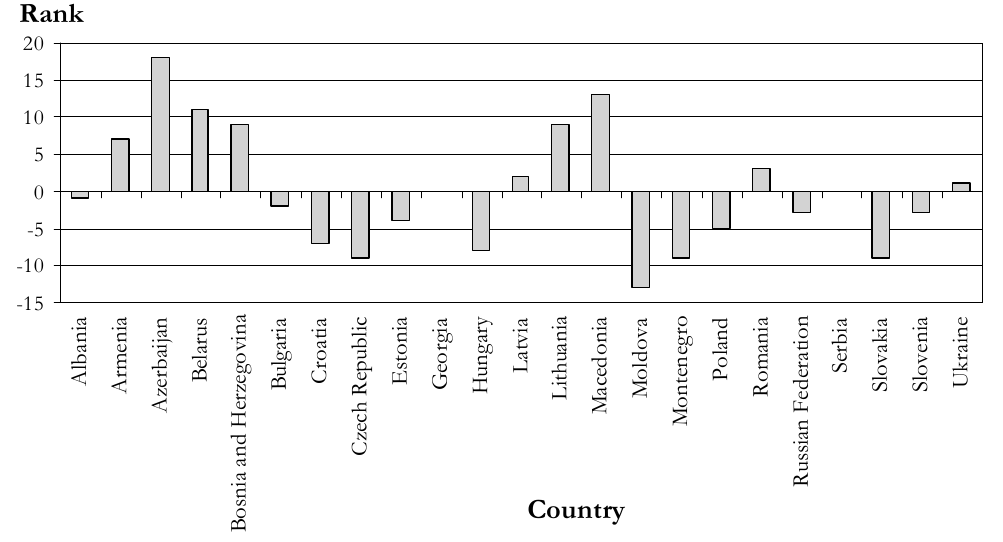
Figure 1. Dynamics of the differences between the rankings based on the adjusted citation index in 2010 and 2018 for the Central and Eastern European countries. The countries are displayed in ascending order regarding the ranks of the adjusted citation index in 2010.